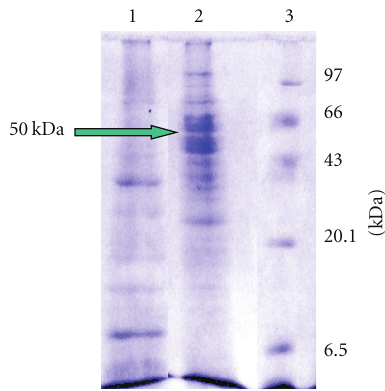
Figure 4: SDS-PAGE analysis of extracellular protein fraction. (1) Control. (2) Extracellular protein fraction from Aeromonas hydrophila strain An4 showing hemolysin (50kDa). (3) Protein molecular weight